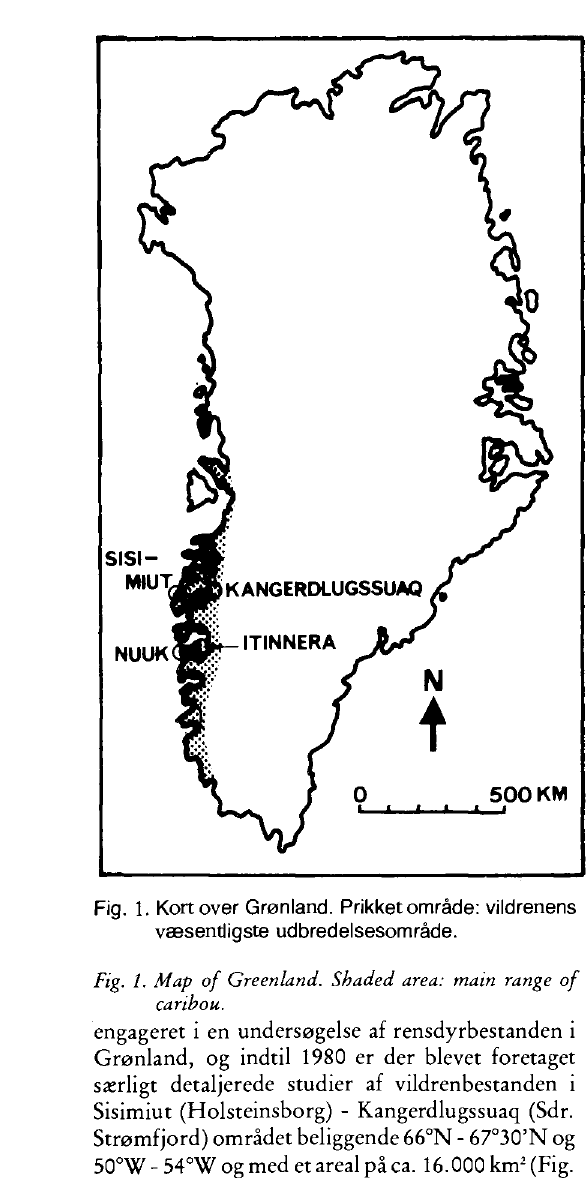
Fig. 1. Kort over Grønland. Prikket område: vildrenens væsentligste udbredelsesområde. Fig. 1. Map of Greenland. Shaded area: main range of caribou.